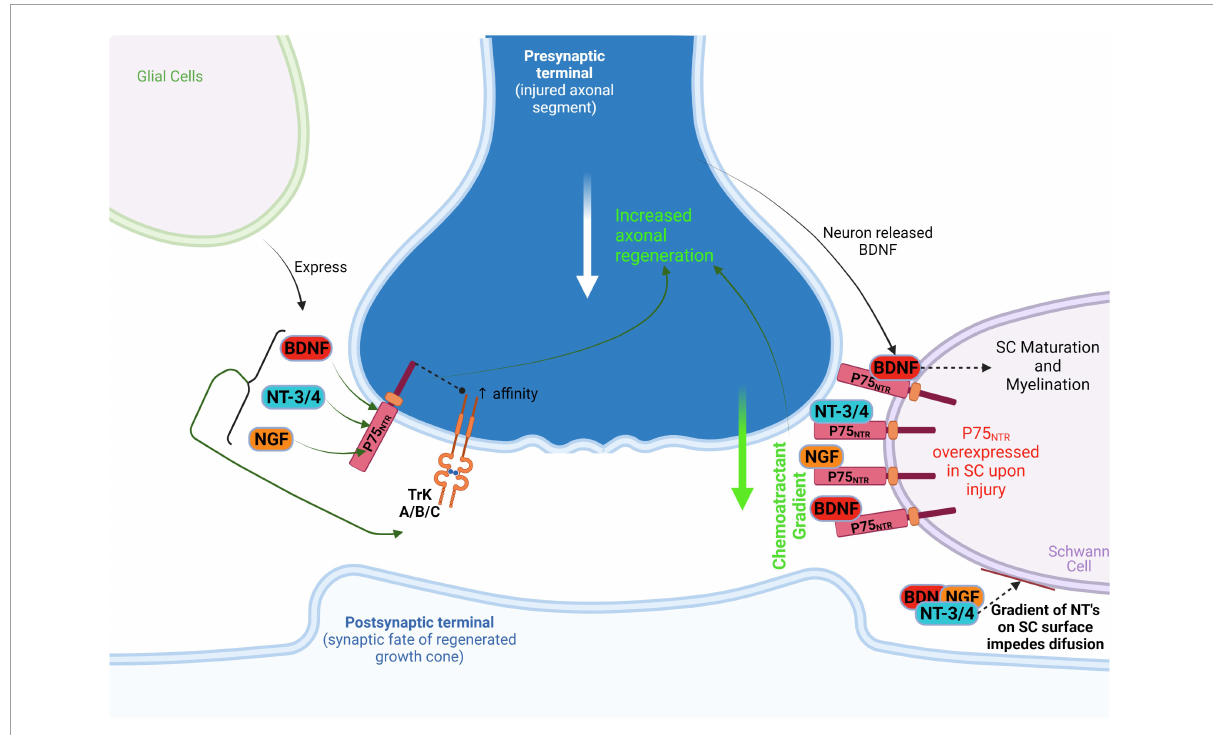
FIGURE1 Schwann cellprotect (SC) action on PNS regenerative axonal guidance: the role of P75 NTR . After injury, SC overexpresses P75 NTR which acts as a neurotrophin receptor and as a booster of neurotrophin (NGF, BDNF, NT-3/4) affinity to TrK(A/B/C). In addition, the P75 NTR is suggested to act as a presenting molecule at SC surface for autocrine neurotrophins in degenerating/injured neurons, thus preventing diffusion of these neurotrophins on SC and generating a chemoattractant gradient that guides/attracts axons. This process leads to axonal regeneration toward non-injured distal neurons. Neuronal released BDNF acts on SC P75 NTR to promote SC maturation and myelination, perpetuating this chemoattractant gradient as well. BDNF, brain-derived neurotrophic factor; NT-3/4, neurotrophins 3 and 4; NGF, nerve growth